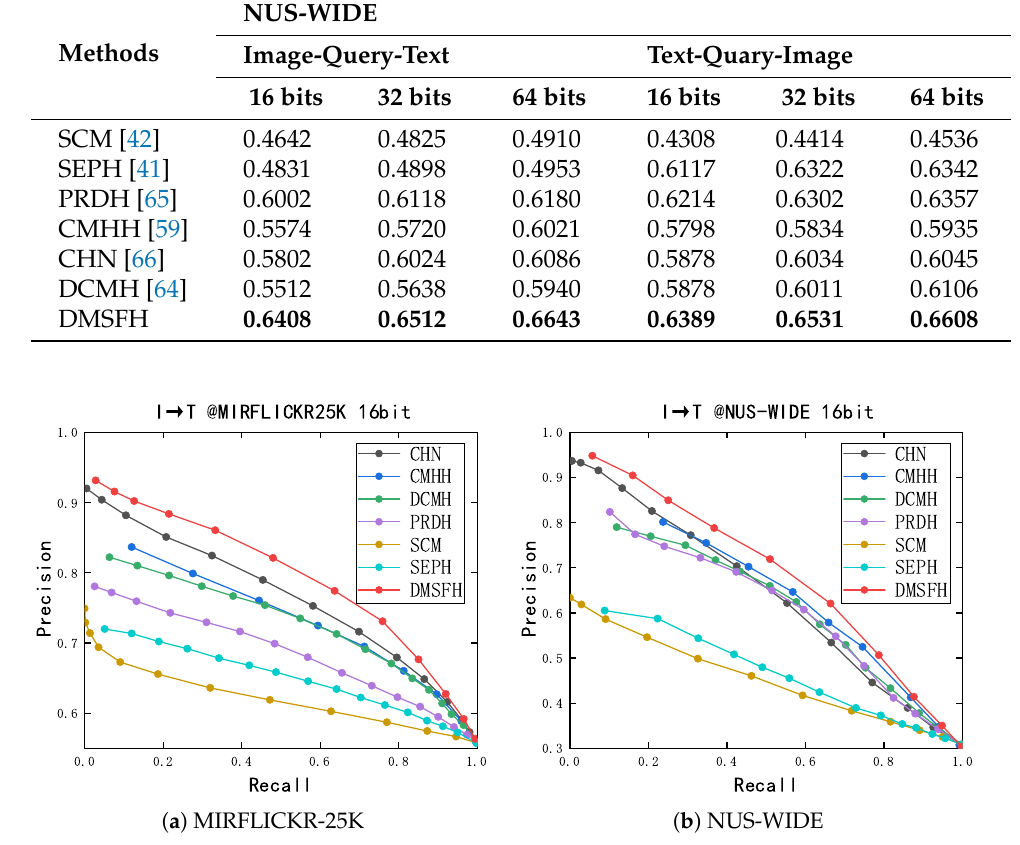
Table 4. Mean average precision (MAP) comparison on NUS-WIDE. The best results are in bold font.